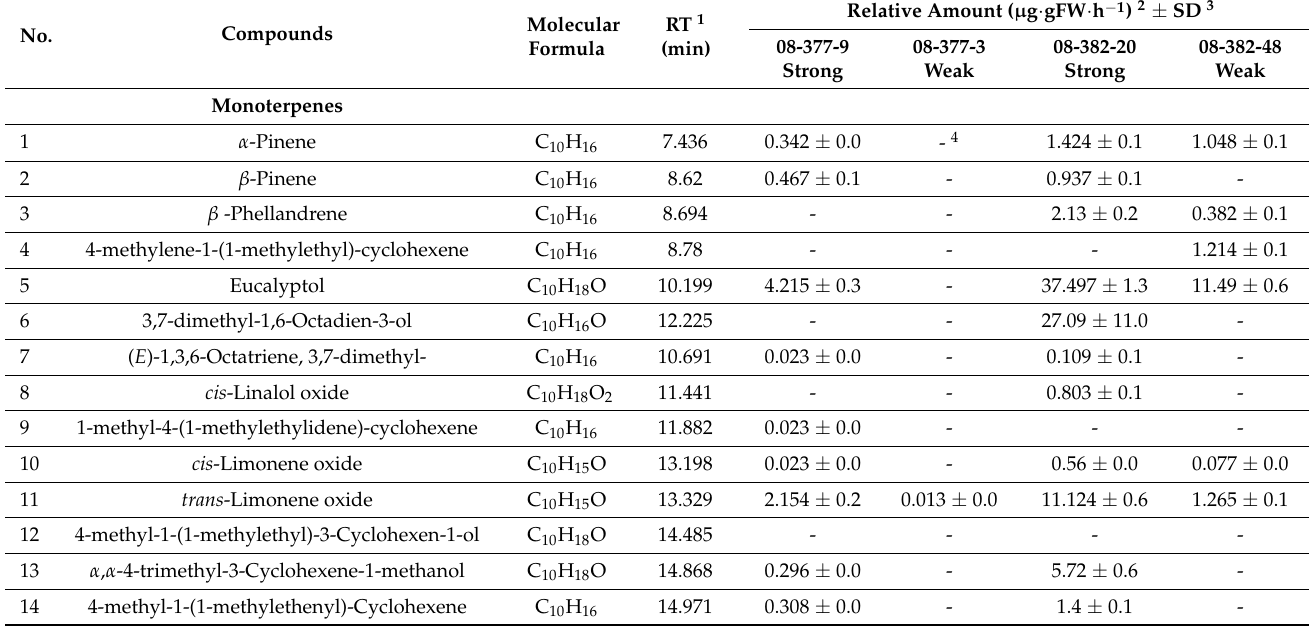
Table 3. Relative amounts of volatile compounds identified in F1